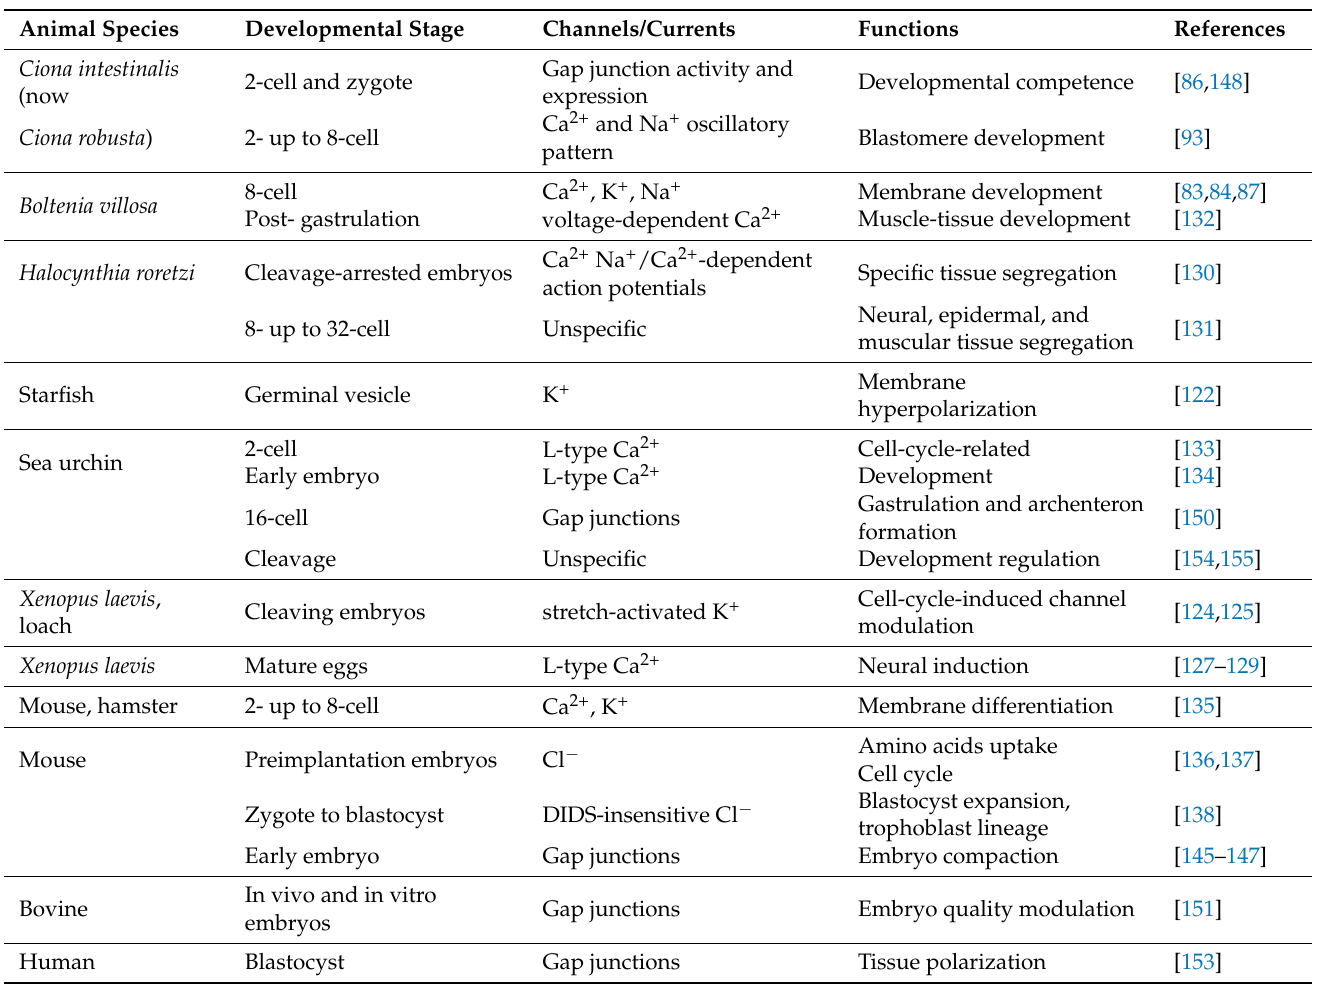
Table 4. Types and functions of ion channels/currents involved in early embryo development in animals and